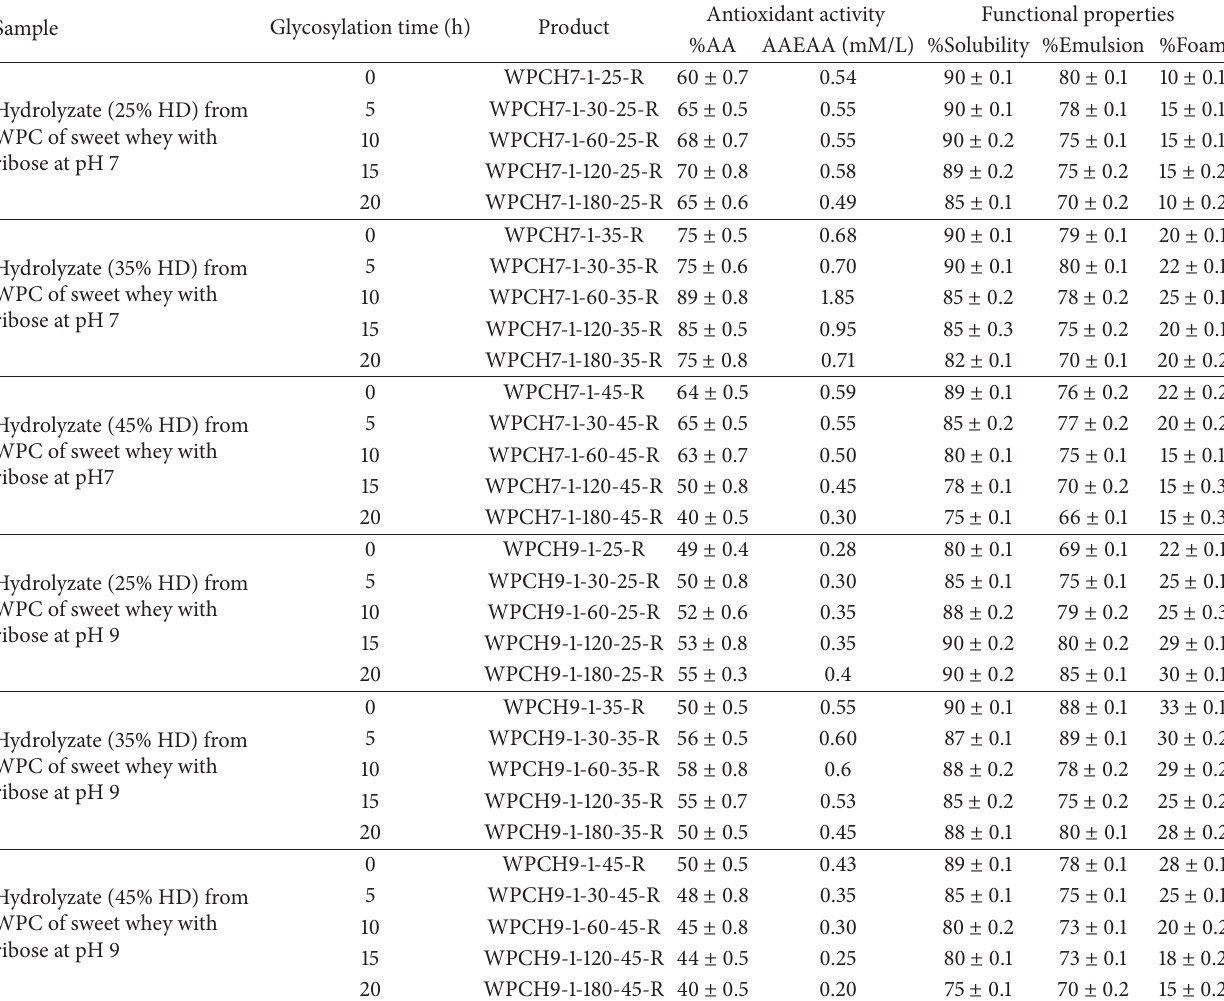
Table 5: Features of glycosylated product from hydrolyzates from WPC of sweet whey with ribose heating to 50 ∘ C, pH 7 and pH 9.